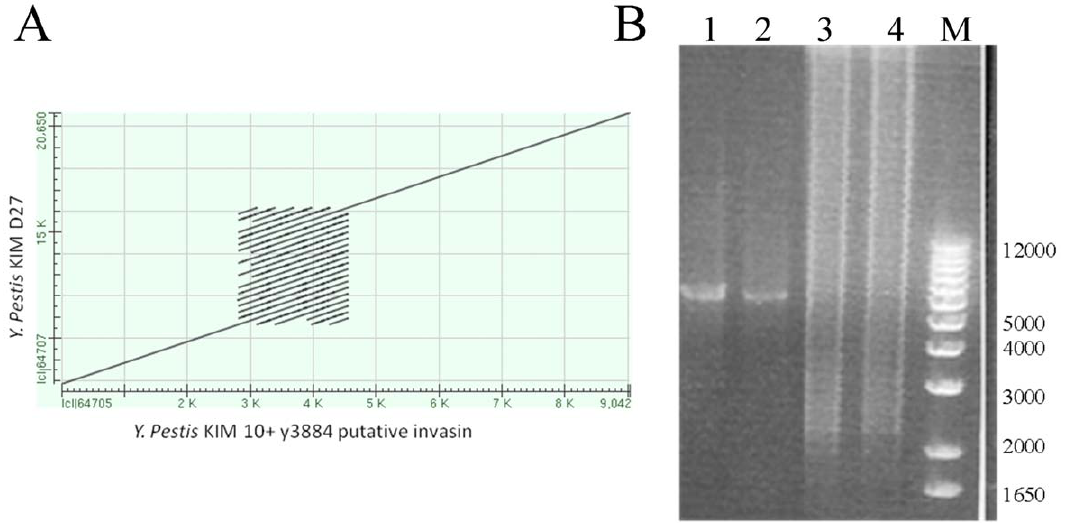
Figure 2. A. Nucmer alignement of putative invasin gene from KIM 10 + and KIM D27. Regions of homology are depicted as diagonal lines. The 289 bp repeat aligns with itself numerous times and results in the square pattern. B. PCR amplification of the invasin gene from KIM 10 + and KIM D27. The chromosomal region 4228610 – 4234900 was amplified from genomic DNA from either strain. The predicted 6,290 bp product was observed as the major product from KIM D27 (lanes 1 and 2), but a ladder effect was observed when KIM 10 + DNA was used (lanes 3 and 4). doi:10.1371/journal.pone.0019054.g002 PLoS ONE |